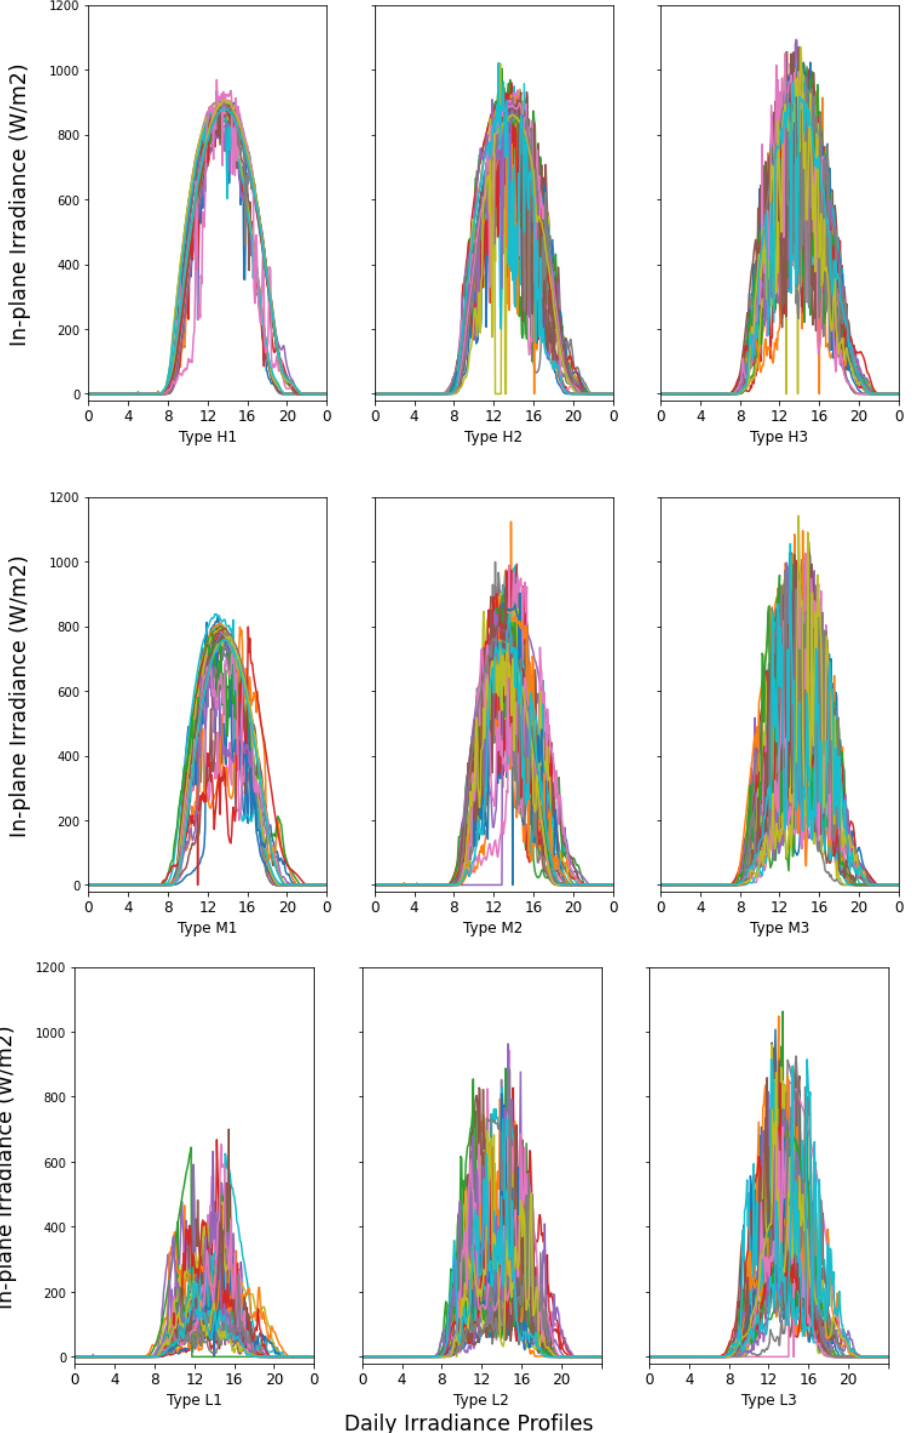
Figure 7. Sample of daily irradiance profiles obtained in the clusters L1, L2, L3, M1, M2, M3, H1, H2 and H3.